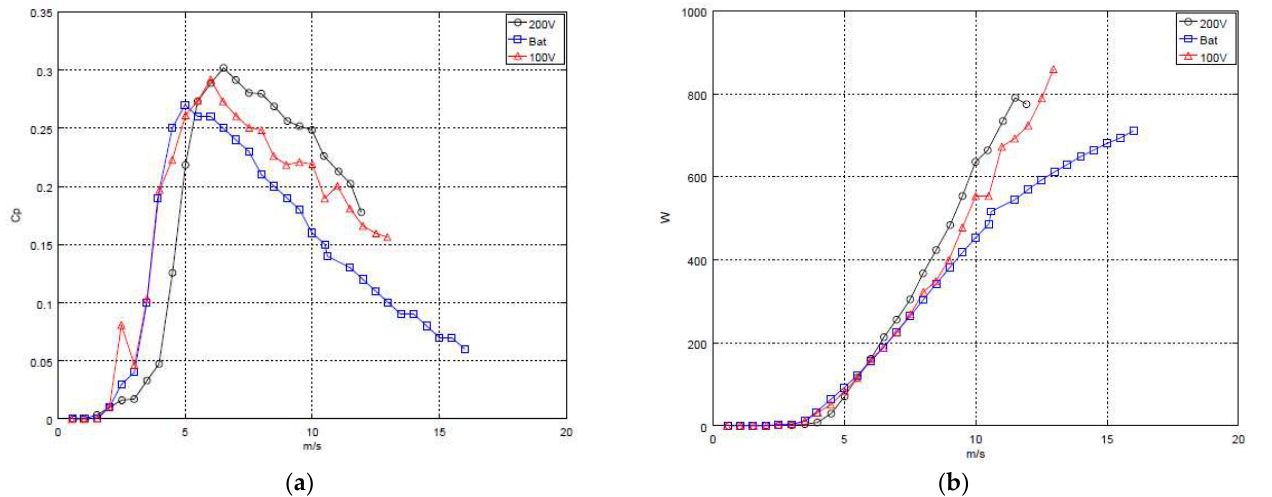
Figure 25. ( a ) Cp–wind speed curves comparison; ( b ) power curves